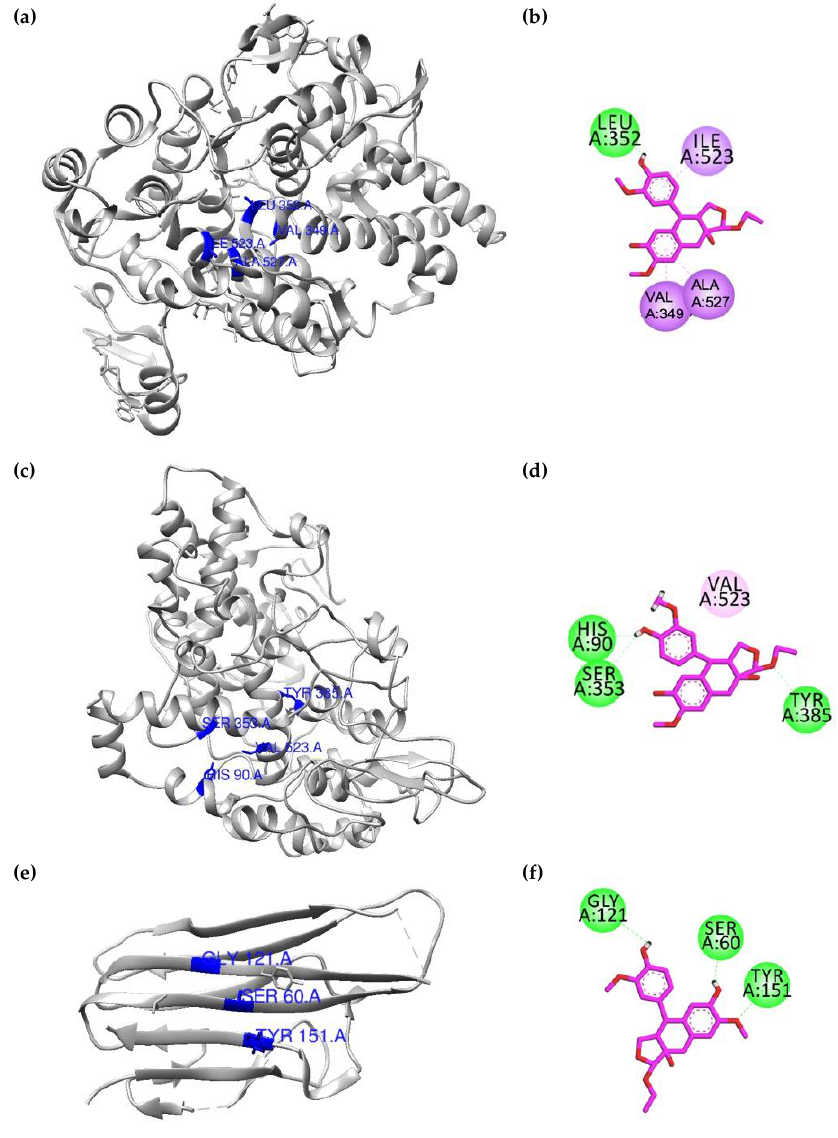
Figure 6. Predicted interaction pattern, in terms of involved residues, for ferruginan with COX-1 ( a , b ), COX-2 ( c , d ), and TNF- α ( e , f ). The targeted amino acids are highlighted, and 2D interaction maps are reported.